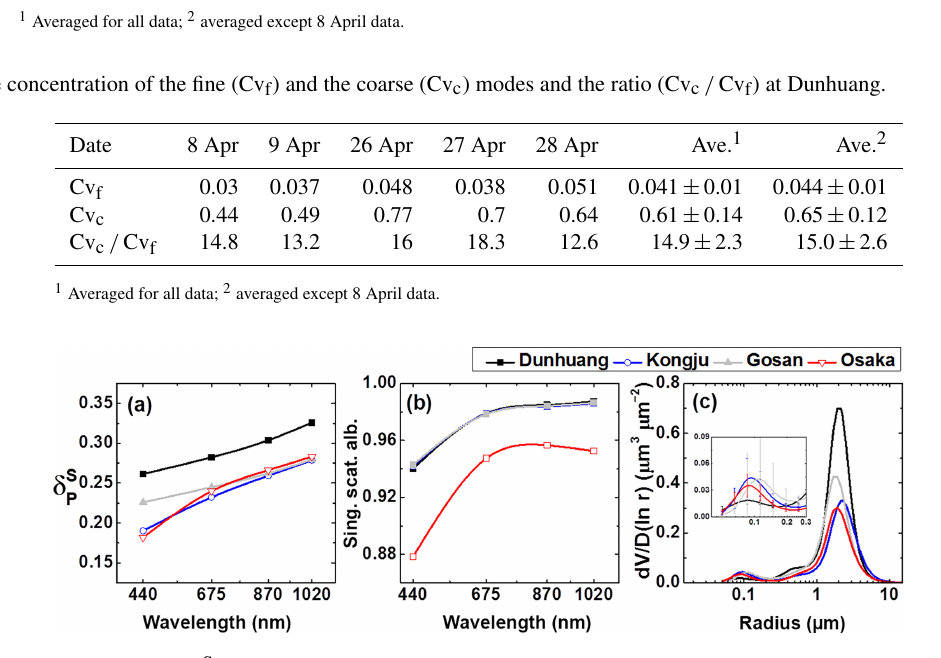
) derived from the sun–sky radiometer data, optical-depth- P